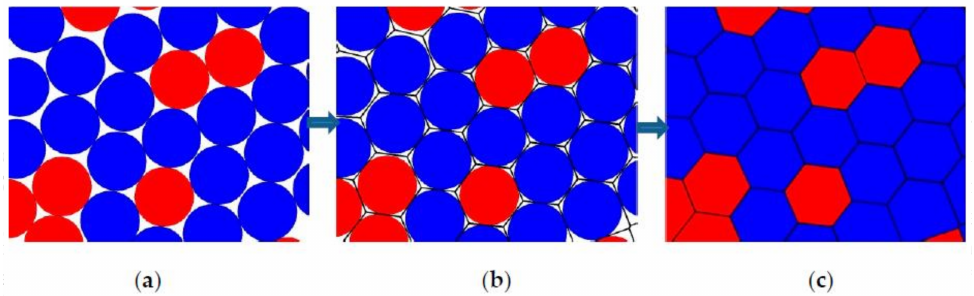
Figure 1. Two-dimensional illustration for constructing dual-phase (DP) steel microstructure with the Voronoi modelling method based on the random close packing of spheres (RCPS-VM): ( a ) DP RCPS; ( b ) computing the Voronoi diagram; ( c ) DP steel